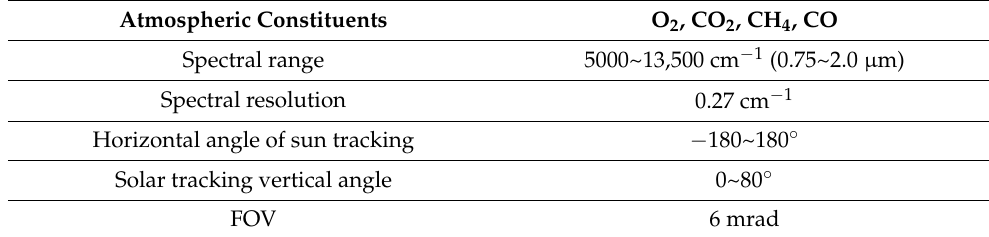
Figure 1. The overall composition block diagram of HRFTS. Table 1. Main performance index of HRFTS.